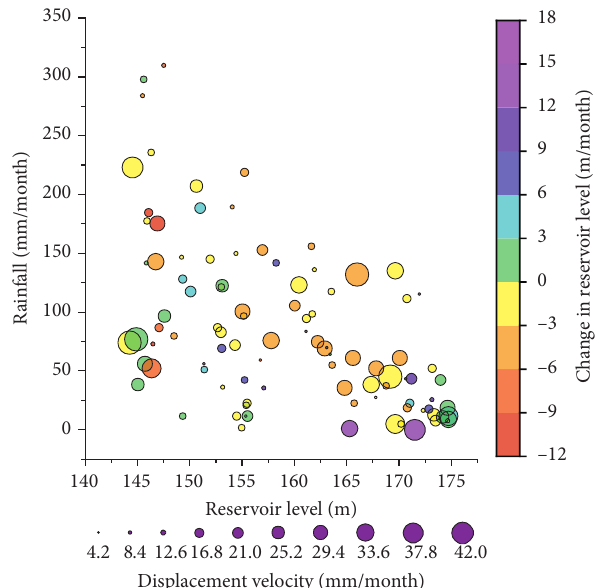
Figure 7: Correlation of the displacement velocity at ZG289 with the reservoir level, rainfall, and reservoir level change.